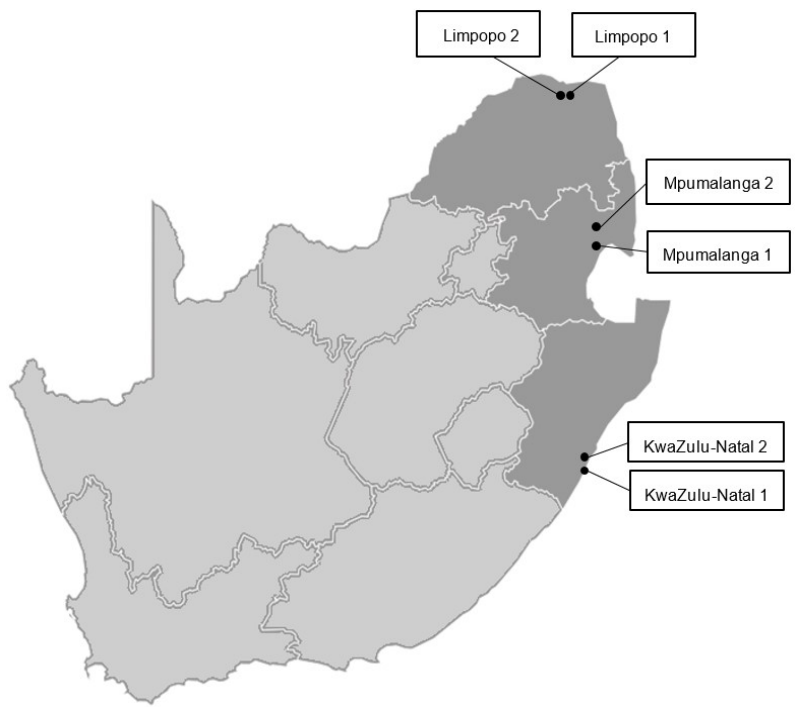
Figure 1. Map of South Africa showing the farm locations where stink bugs were sampled in KwaZulu-Natal, Limpopo and Mpumalanga (indicated in grey).